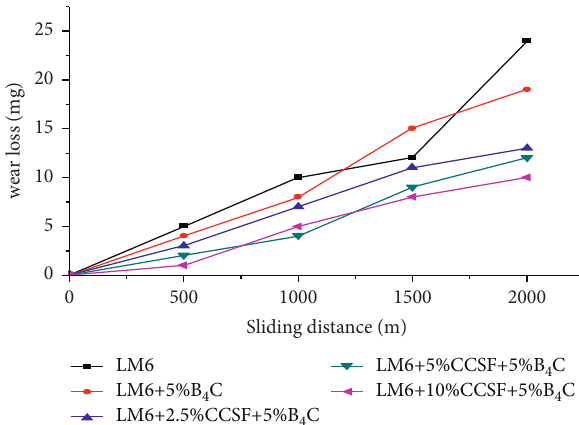
Figure 12: Wear losses with varying sliding distance of LM6 Al alloy and hybrid